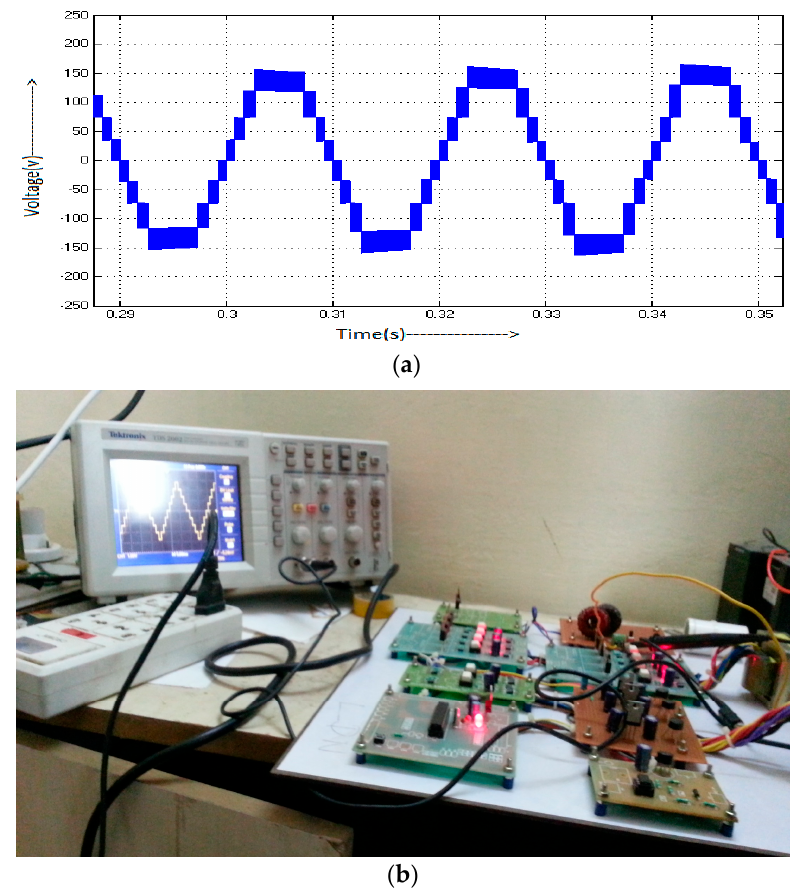
Figure 20. ( a ) Hardware output of MLI unit and ( b ) Hardware prototype setup.